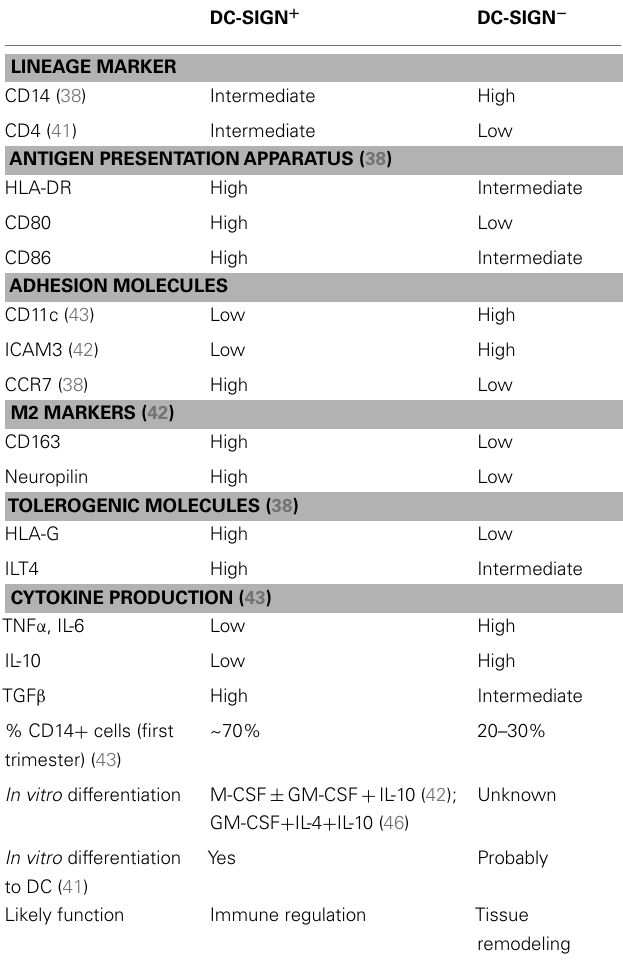
Table 1 | Differences between decidual DC-SIGN + and DC-SIGN −